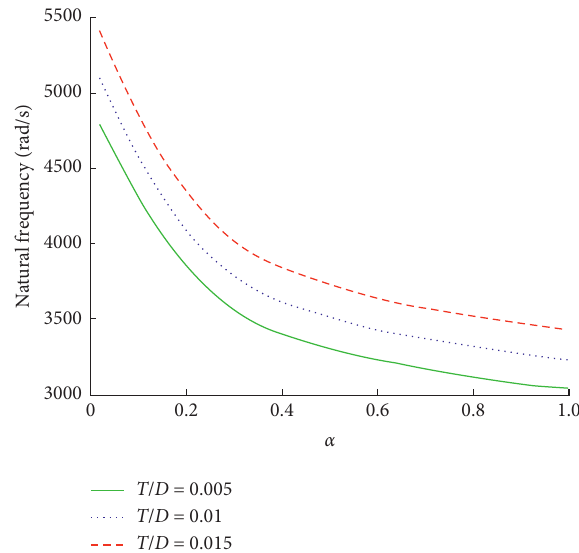
Figure 5: Natural frequency of the tapered composite boring bar with different T / D